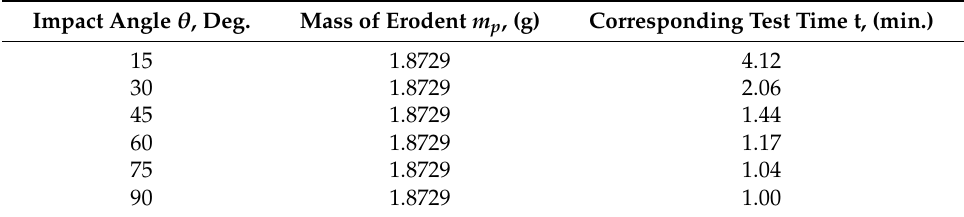
Table 4. Test-time corresponding to the impact angle for the same mass of erodent ( m p = 1.8729 g). Impact Angle θ ,